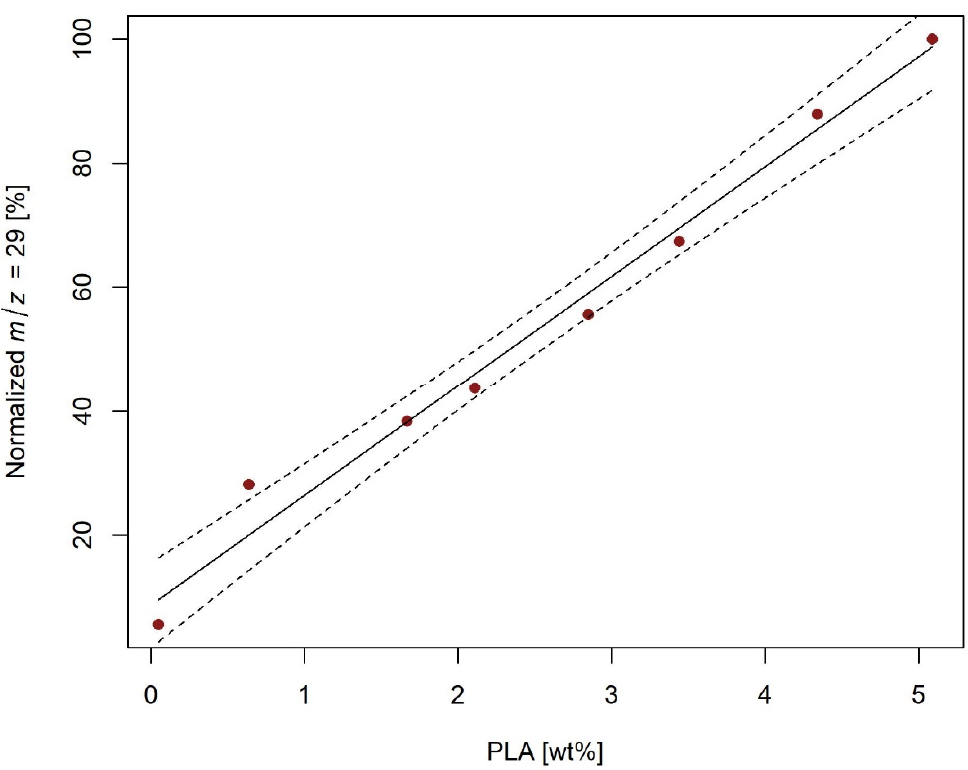
Figure 5. Calibration line for determination of PLA in P185 soil by detection of degradation products with m / z 29; dashed line indicates 95% confidence interval.